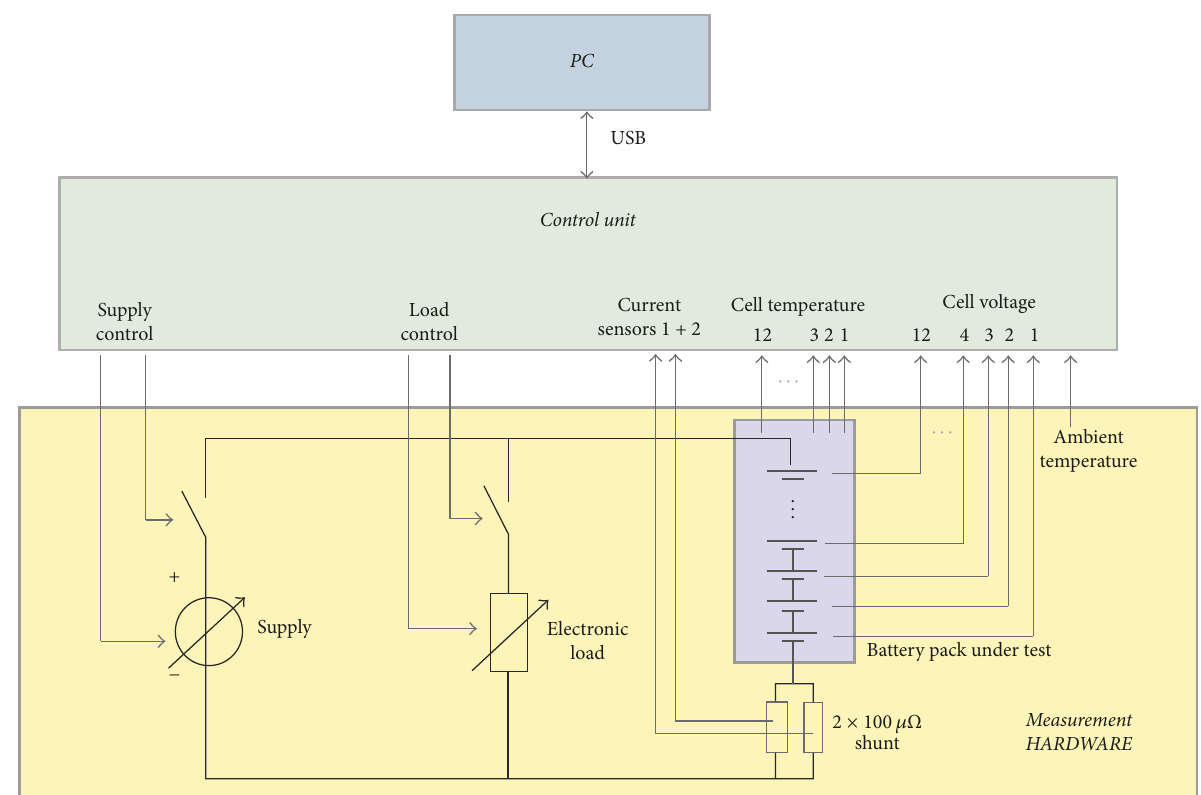
Figure 4: Block scheme of the measurement